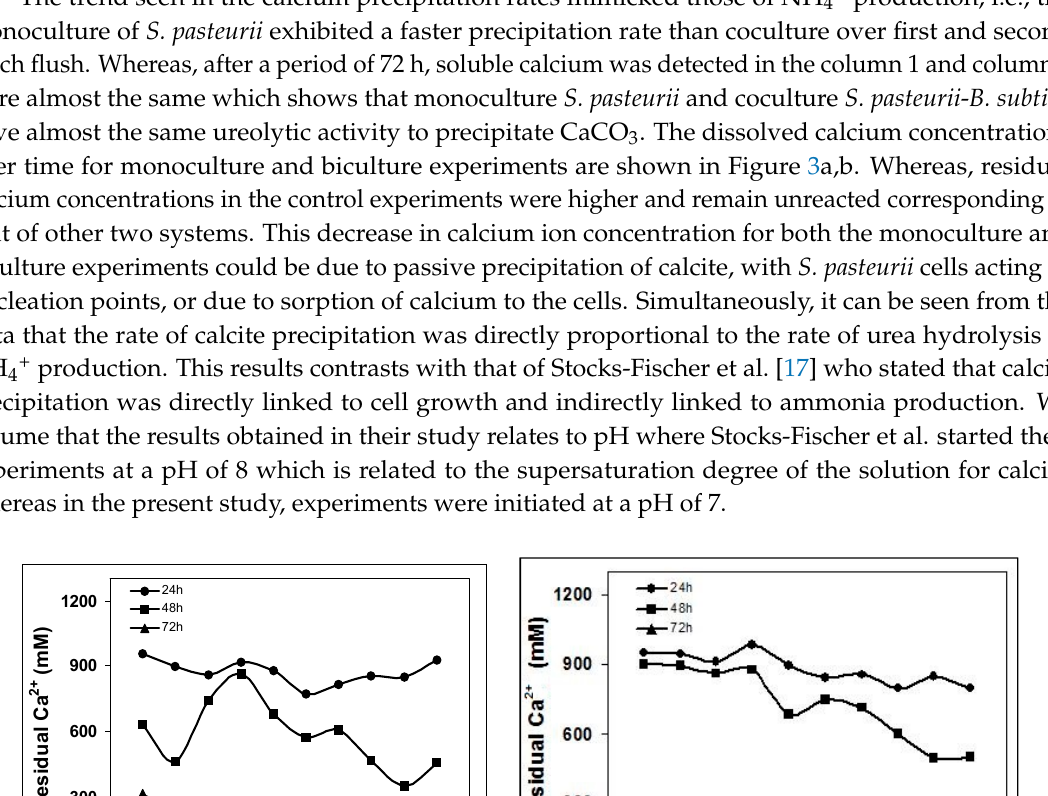
Figure 2. ( a ) Ammonium concentration measurements in the effluent for monoculture S. pasteurii , which was flushed out after 24 h, 48 h and 72 h respectively; ( b ) Ammonium concentration measurements in the effluent for coculture of S. pasteurii and B. subtilis , which was flushed out after 24 h, 48 h and 72 h, respectively.